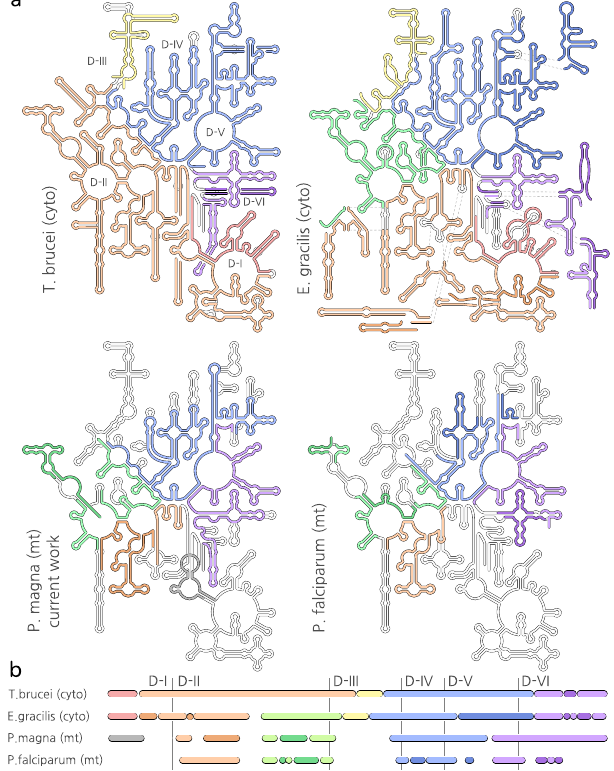
Fig. 4 | LSU rRNA fragmentation patterns. a Comparison of mitochondrial LSU rRNA from P. magna and P. falciparum and cytosolic LSU rRNA from T. brucei (PDBID: 4V8M) and E. gracilis (PDBID: 6ZJ3) highlights similar fragmentation pat- terns. Fragments spanning equivalent regions of the rRNA secondary structures coloured by hue, individual fragments highlighted by colour brightness. E.coli reference diagram as a white background. b Linear representation of the fragments ’